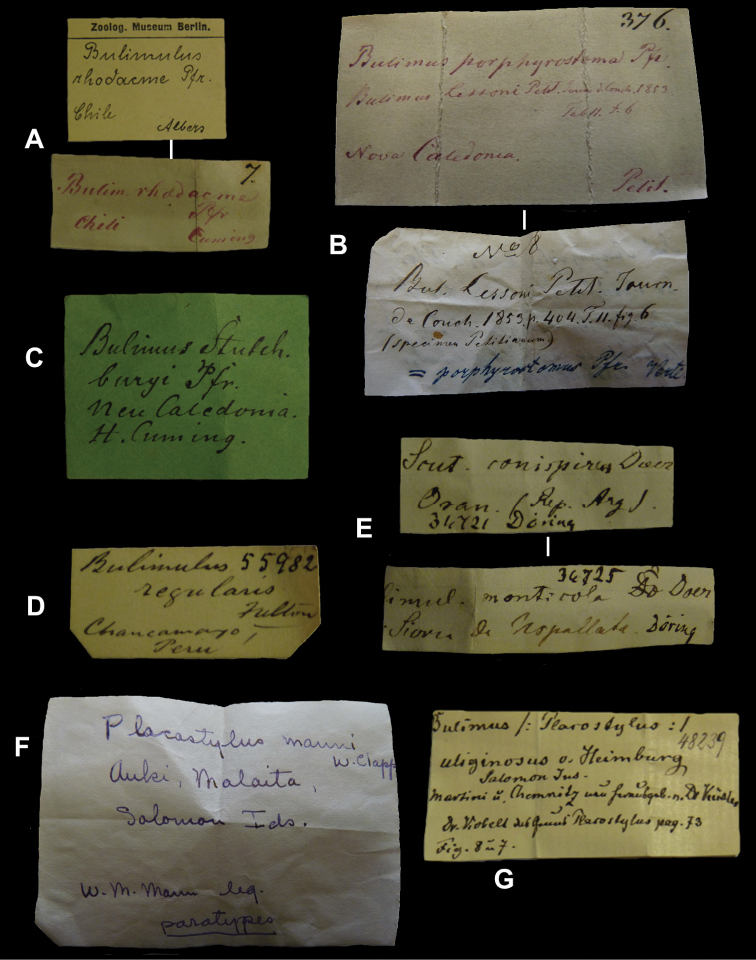
Labels with author’s handwriting. A–B Two different series of labels originating from Albers, one (A) without the original label, the other (B) with the original label (in this case from Petit); note that the lower line is in L. Pfeiffer’s hand C W. Dunker D H.C. Fulton E Two labels with partly the handwriting of A. Doering, and partly written in Martens’ hand (the numbers and the second occurrence of Doering’s name (“Döring”)). Note the two different inks on the lower label F W.F. Clapp G H. von Heimburg.